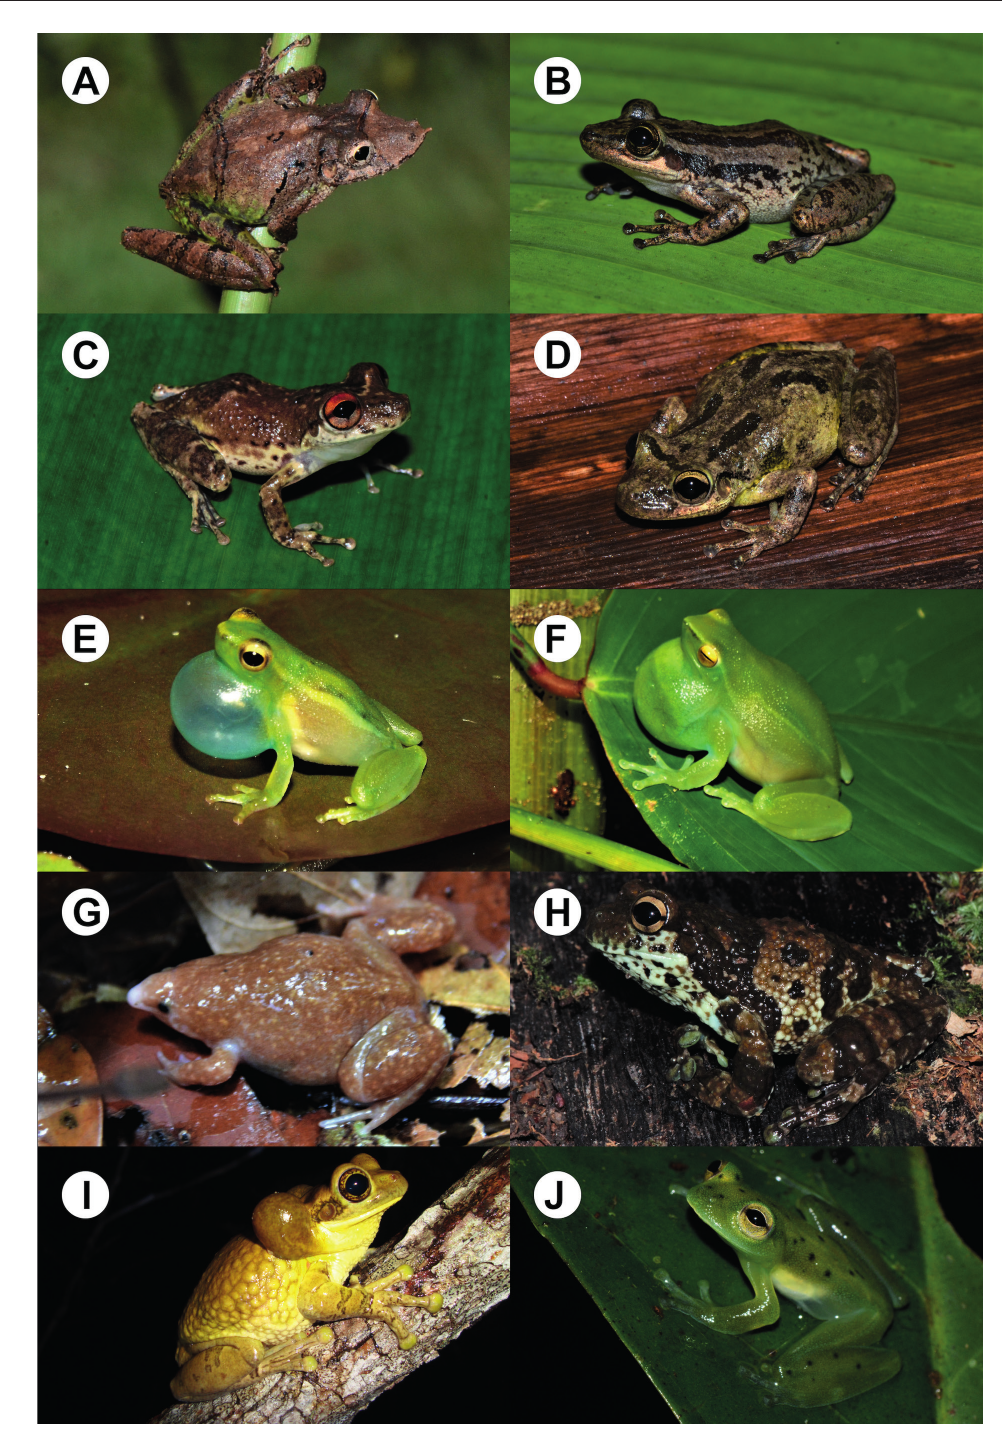
Fig. 9. Anuran species recorded in the state of Amapá. A . Scinax proboscideus (Brongersma, 1933). B . Scinax ruber (Laurenti, 1768). C . Scinax ruberoculatus (Ferrão, Fraga, Moravec, Kaefer & Lima, 2018). D . Scinax x-signatus (Spix, 1824). E . Sphaenorhynchus carneus (Cope, 1868). F . Sphaenorhynchus lacteus (Daudin, 1800). G . Synapturanus zombie Fouquet, Leblanc, Fabre, Rodrigues, Menin, Courtois, Dewynter, Hölting, Ernst, Peloso & Kok, 2021. H . Trachycephalus hadroceps (Duellman & Hoogmoed, 1992). I . Trachycephalus typhonius (Linnaeus, 1758). J . Vitreorana ritae (Lutz, 1952). Photos: C.E.